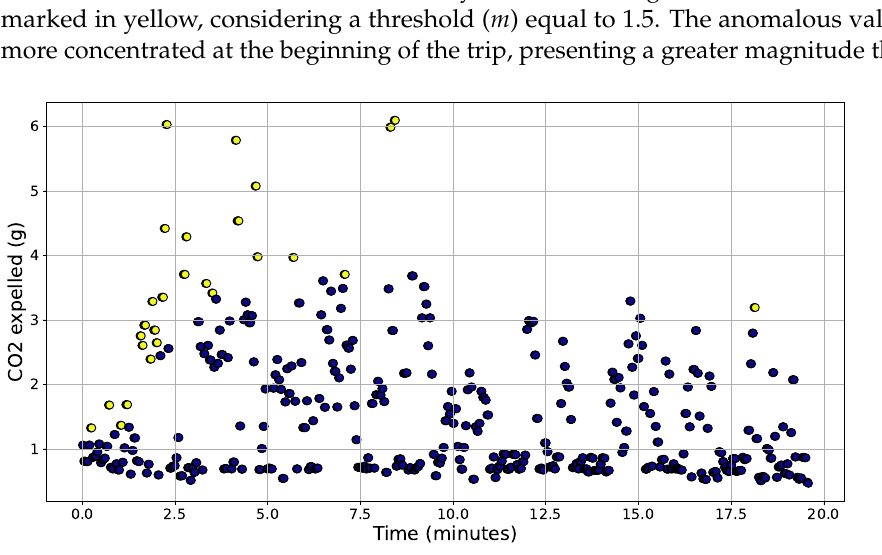
Figure 7. Application of the TEDA algorithm on the Monday dataset using m =